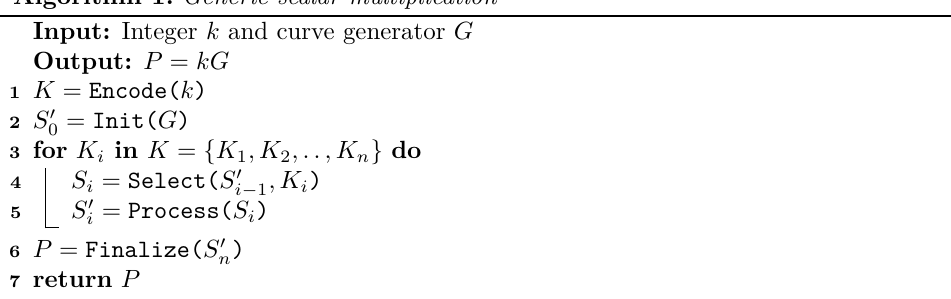
Algorithm 1: Generic scalar